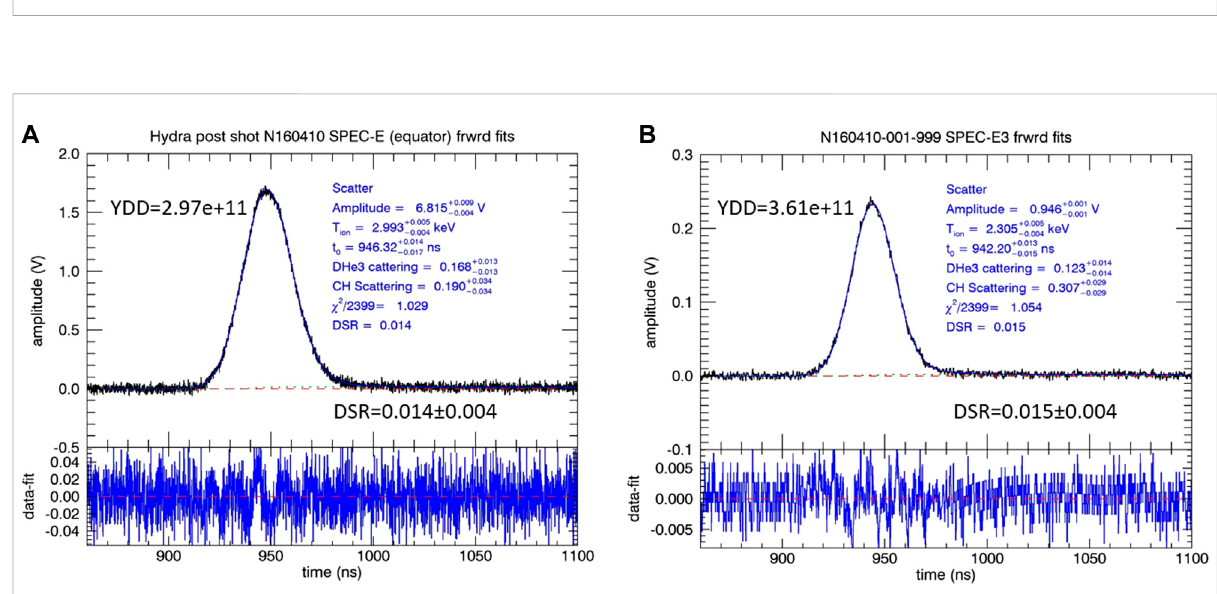
FIGURE 8 The result of aforward fi t model to, (A) thedata from shot N160410 – 001 and (B) of thesynthetic neutron time-of- fl ight spectrum generated in post-shot Hydra simulation. Included in the forward fi t model are the effects of neutron scattering from the CH ablator shell and the compressed D 3 He fuel. The “ down scatter ratio, ” DSR, is fraction of yield for neutrons of energy 1.9 – 2.2 MeV divided by the yield from 2.2 to 2.7